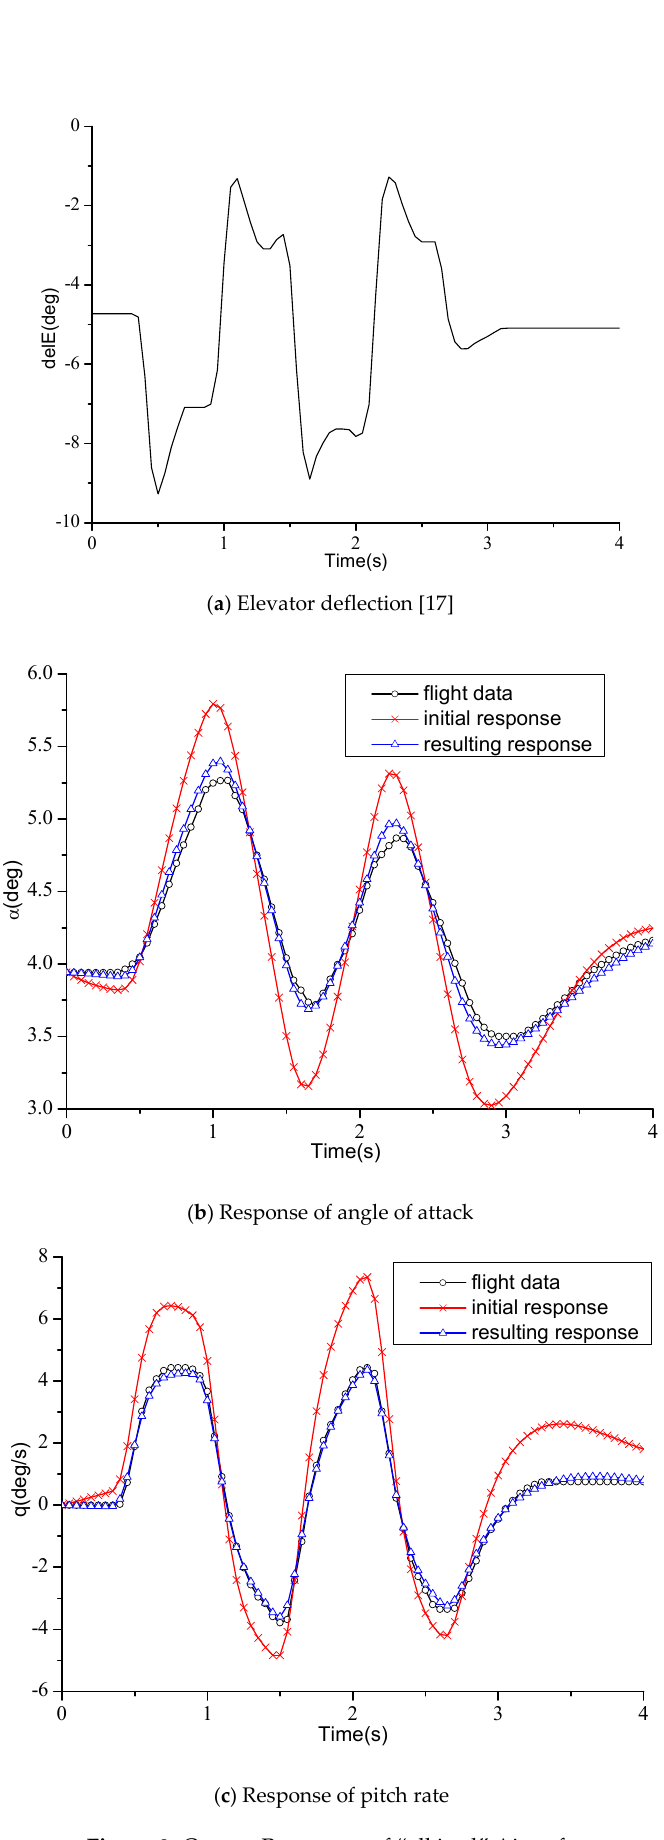
Figure 8. Output Responses of “all iced” Aircraft. Table 8. Identification results of artificially iced aircraft.